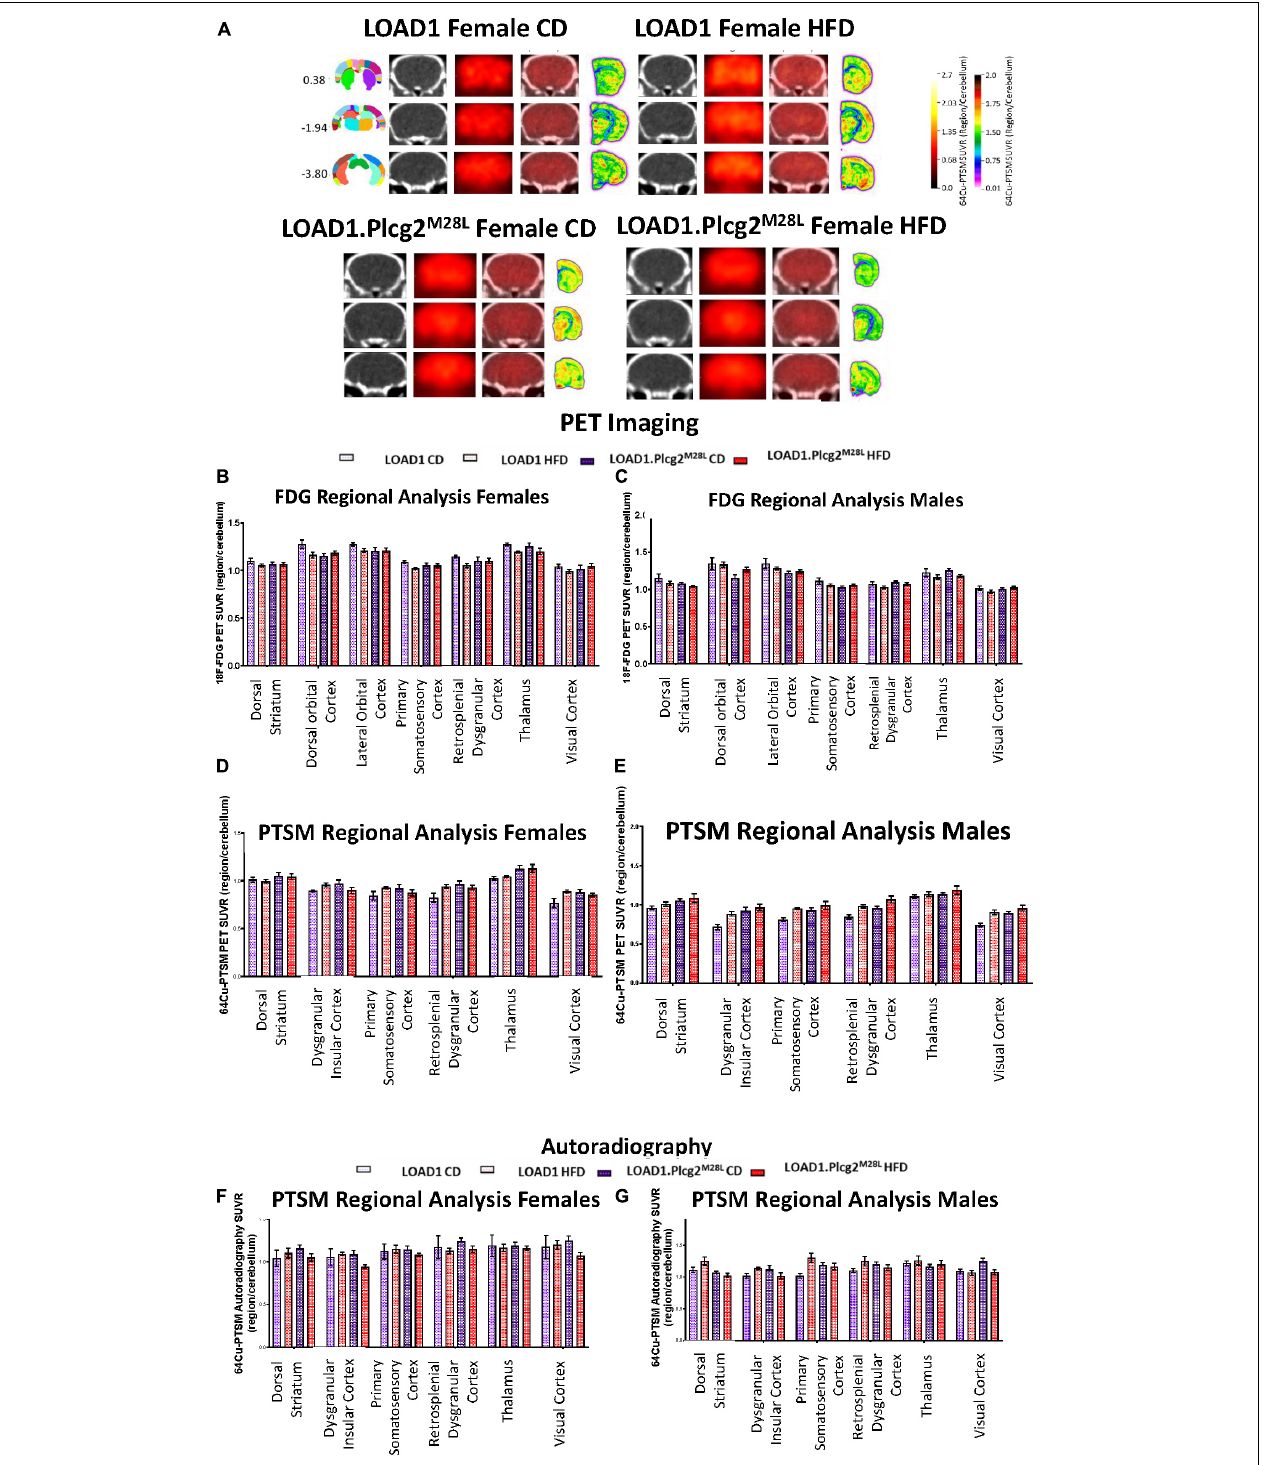
FIGURE 6 | In vivo PET/CT imaging of LOAD1.Plcg2 M 28 L fed with HFD. Representative images for 64 Cu-PTSM PET/CT and autoradiography of randomly selected 12-months old female LOAD1.Plcg2 M 28 L mice following 10-month HFD treatment (A) . In all cases, images are presented as standardized uptake value ratios (SUVRs) to the cerebellum. Representative bregma image panel presented as average CT (left), PET (center-left), Fused (center-right), and Autoradiography (right). Data presented are the brain regions that explain 80% of the variance determined using Principal Component Analysis (PCA) in brain glycolysis (B,C) and brain perfusion (D,E) in both females (B,D) and males (C,E) . Following the terminal 64 Cu-PTSM scans, the brains were subjected to autoradiographic analysis (F–G) . Data presented are the brain regions that explain 80% of the